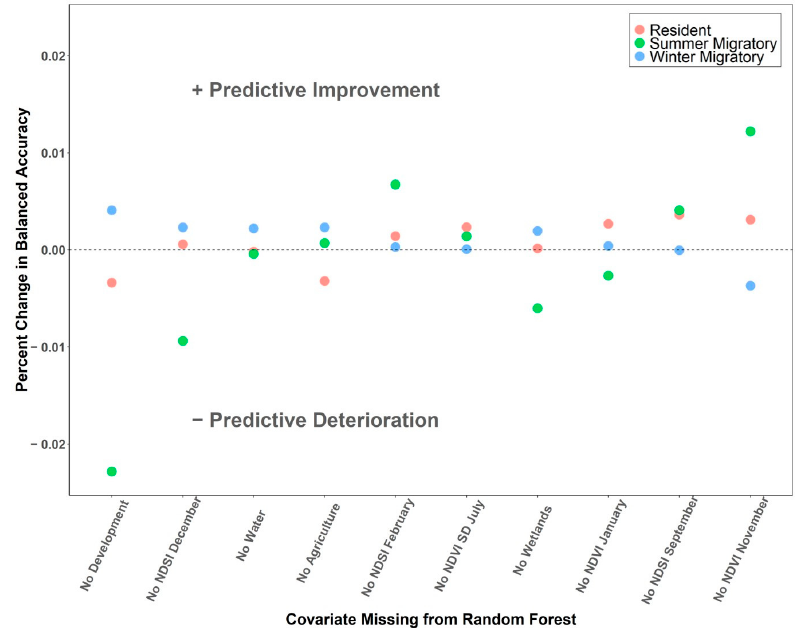
Figure 6. The changes in balanced accuracy with the take-one-out random forest method. After running the initial random forest, we reran ten random forests, each missing one of the ten top ranked variables from the initial random forest, to further assess the importance of each variable. To quantify how removing these predictors affected the prediction, from each random forest, we calculated the balanced accuracy (average of the true positive rate and the true negative rate) of the confusion matrix for the full dataset of 42 mule deer. We then calculated the percentage change in the balanced average for each predicted niche type by comparing this with the initial random forest, including all variables. A negative percentage change demonstrates worse predictive accuracy by removing the given predictor from the model. Red points are predicted resident niches, green points are predicted summer migratory niches, and blue points are predicted winter migratory niches.